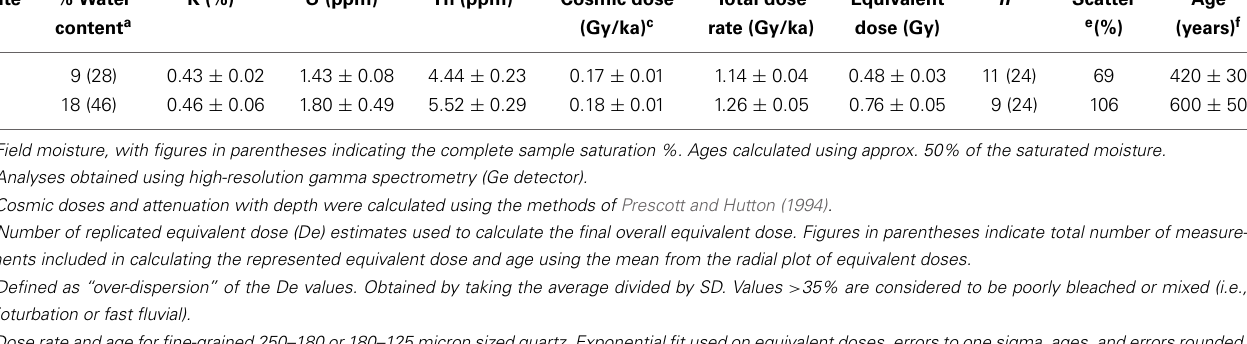
Samples analyzed by the NSF-Arizona AMS Laboratory.